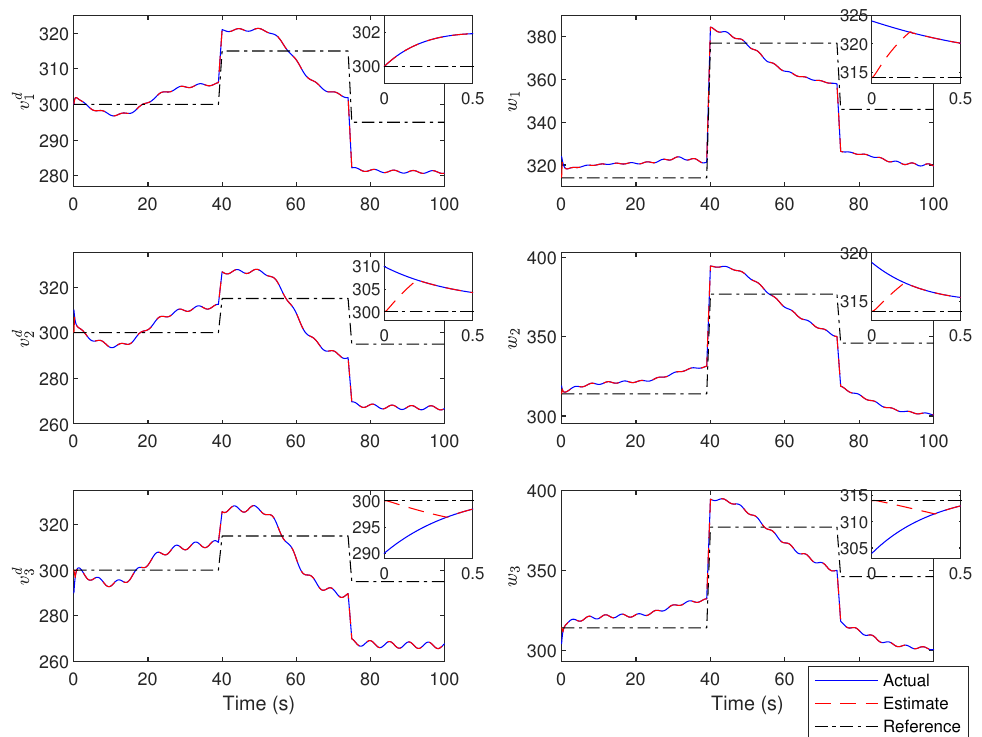
Figure 9. The states of system (53) (solid), their estimates from the distributed SMOs (dashed), and the reference value (dash-dotted) for the case where u d , i = 0 for i = 1,2,3.